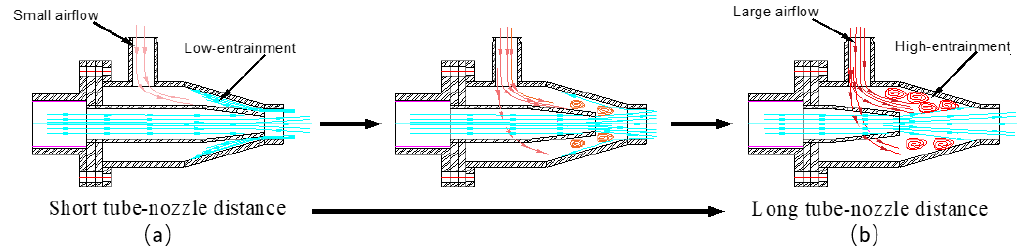
Figure 6. Effect of nozzle outlet closure degree on suction and vorticity variation under different tube-nozzle distances. ( a ) Diagram of suction and vorticity variation under short tube-nozzle distances. ( b ) Diagram of suction and vorticity variation under long tube-nozzle distances.